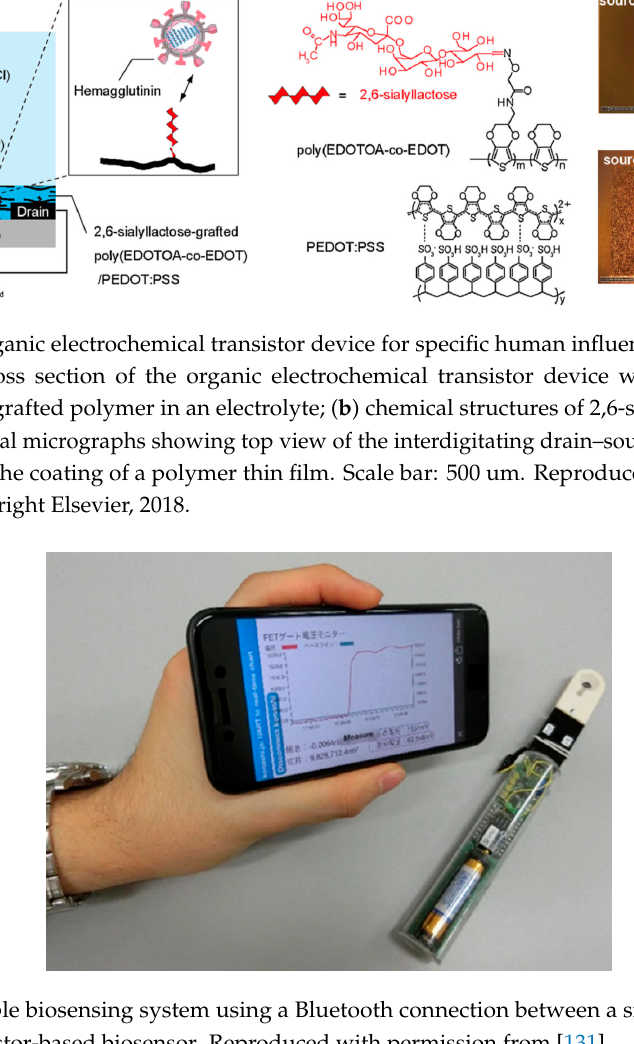
Figure 18. Rise of lateral stress inside the polymer receptor layer with sialyloligosaccharide groups after binding virus particle. Reproduced with permission from [132]. Copyright the Royal Society, 2019. The characteristics of nanoscale-based glycan biosensing platforms are summarized in Table 5. Table 5. Nanoscale-based platforms for construction of nanobiosensors and their characteristics. Carbohydrate